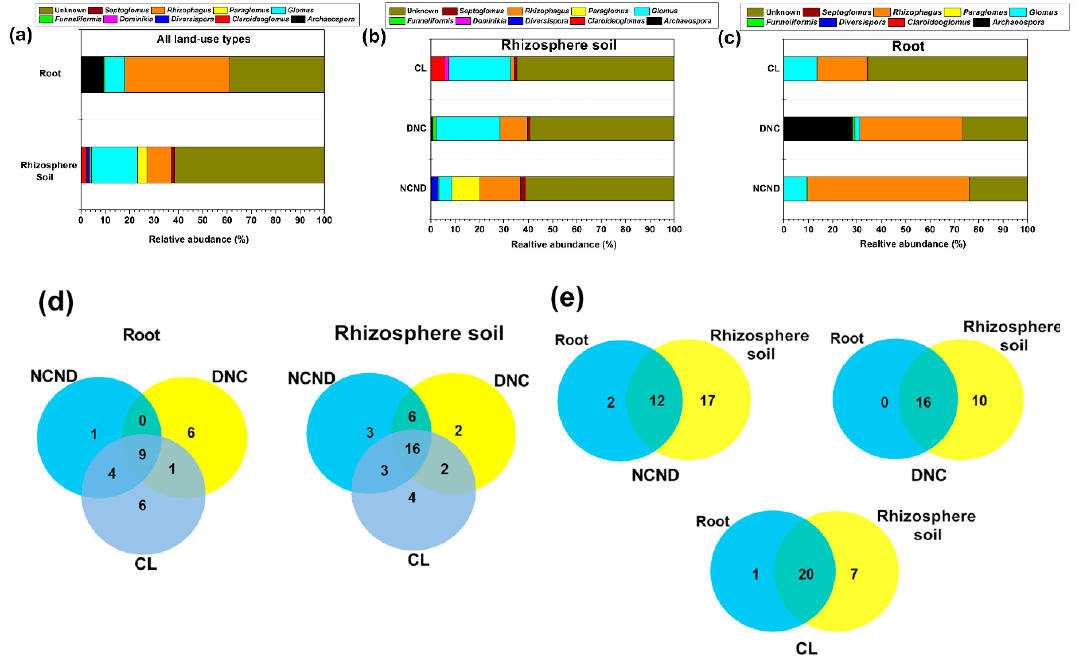
Figure 2. Variations of relative abundances of arbuscular mycorrhizal fungal (AMF) taxa in the roots or rhizosphere soils of C. dactylon in all of the three land-use types ( a ), in the rhizosphere soils ( b ), roots ( c ), the Venn diagram of AMF taxa among three contrasting land-use types ( d ) and between soils and roots under each land-use type ( e ) along the drawdown zone of Three Gorges Reservoir. NCND (non-cultivated non-disturbed land), DNC (disturbed non-cultivated land), and CL (cultivated land).